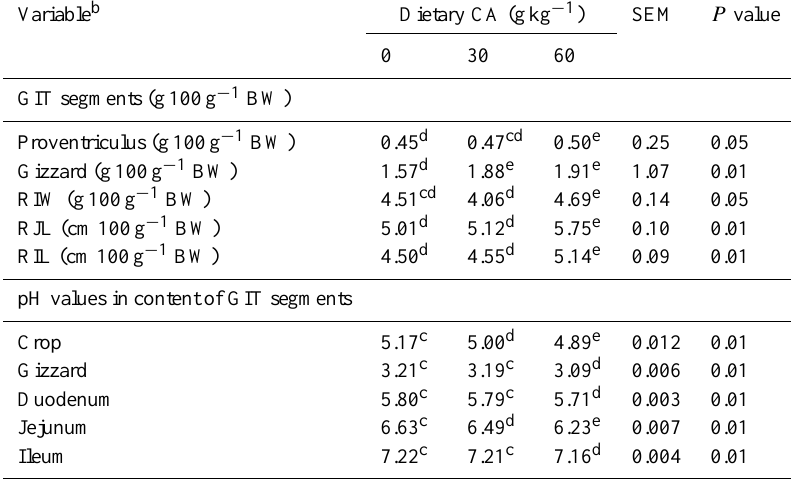
Table 3. Effect of dietary citric acid on weight percentage and pH of contents in certain gastrointestinal tract (GIT) segments of 42-day-old broiler chickens a .